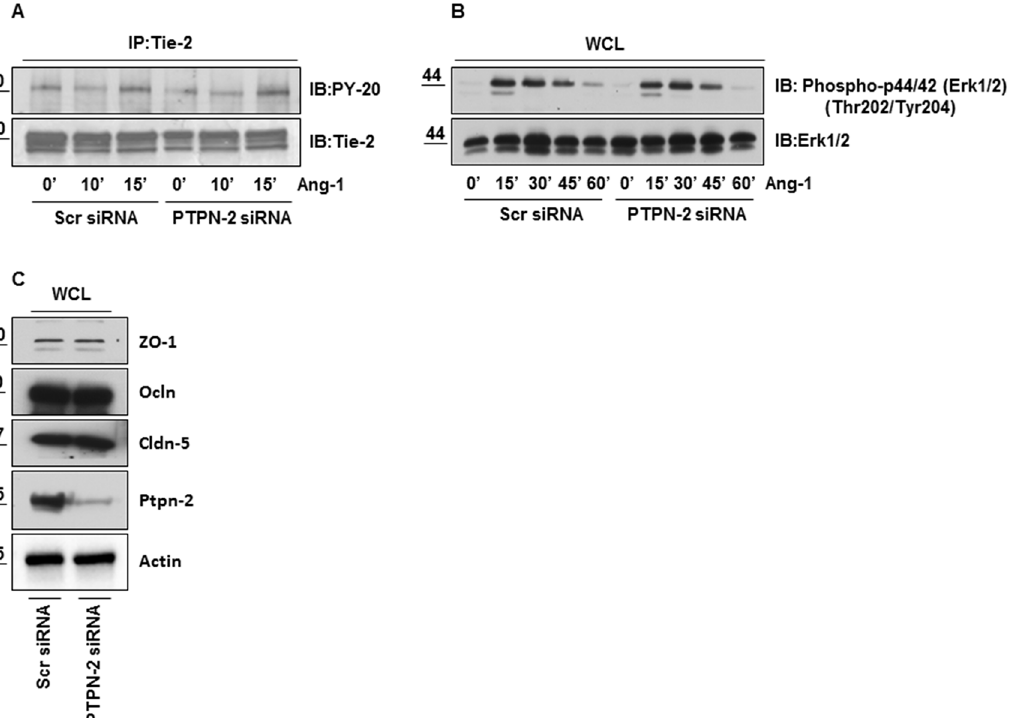
Fig 5. PTPN-2 depletion has no effect on Ang-1 mediated Tie-2 and Erk activation, and on expression of TJ proteins. Scramble and PTPN-2 siRNA transfected HBMECs were activated with 100ng/ml of Ang-1 for indicated times. ( A) Immunoprecipitation of Tie-2 protein followed by immunoblotting with anti-PY-20 antibody; blot was reprobed with anti-Tie-2 antibody. ( B) Whole cell lysates were immunoblotted with anti-Phospho-p44/42 (Erk1/2) (Thr202/ Tyr204) and anti-Erk1/2 antibody. ( C) Whole cell lysates were analyzed by Western blotting to study the expression of major TJ proteins with anti-ZO-1, anti- Occludin, anti-Claudin-5 and anti-PTPN-2 antibody. Actin used for loading